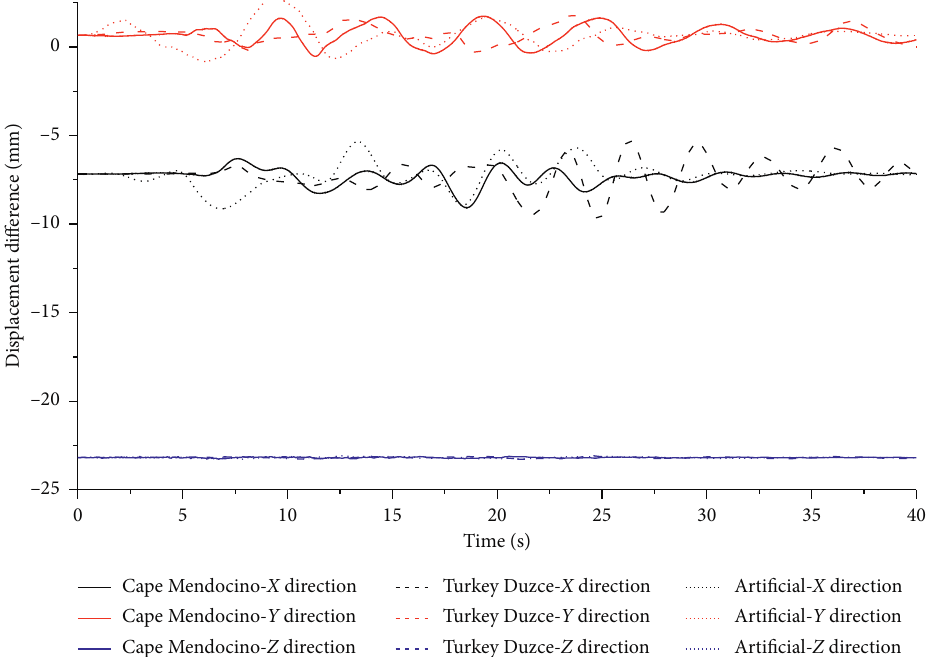
Figure 13: Displacement difference–time curves of climbing formwork and core tube under the construction condition.